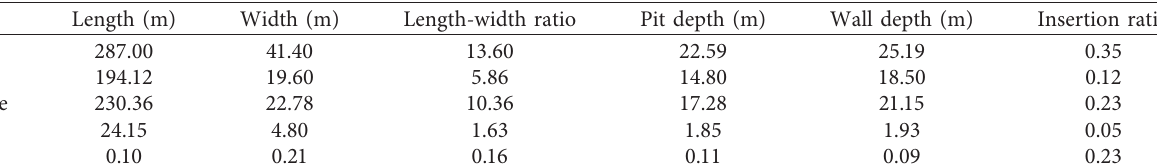
Table 1: Basic information of the metro foundation pit.